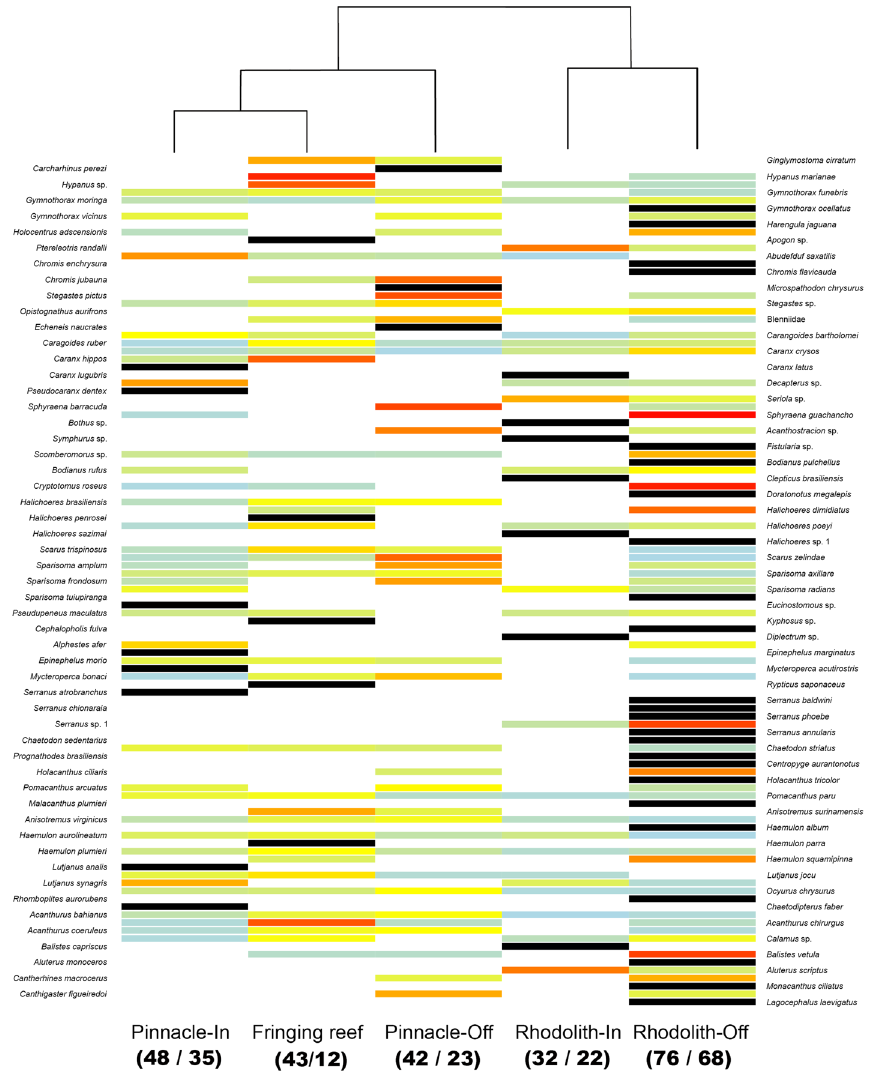
Figure 2. Reef fish abundance in the Abrolhos Shelf. The heatmap was built using relative abundances (rows) weighted by the sampling effort at each sampled strata (columns). Absences are assigned to white, whereas increasing relative abundances are colored from light blue (0.002) to red (0.96). Unique occurrences are shown in black. Column orders were arranged by transforming a matrix of Bray–Curtis dissimilarities among strata into distances (UPGMA). Numbers in parenthesis bellow each habitat column indicate total species richness / number of BRUV deployments. Generated with Freeware R (www.r-proje ct.org), using package